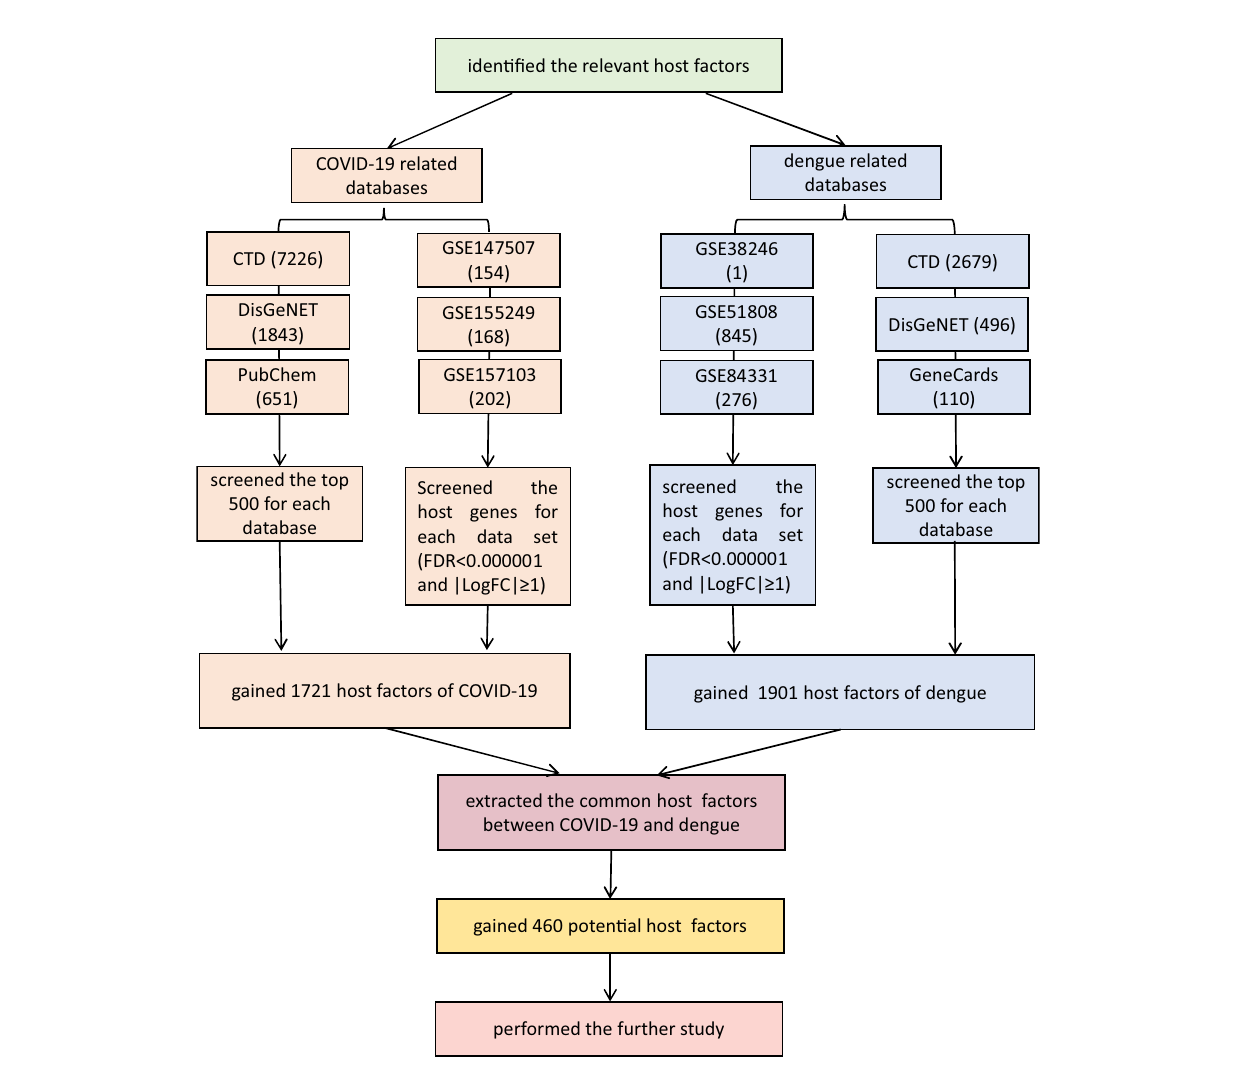
FIGURE 1 | The screening process of shared targets between COVID-19 and dengue. In total, 460 factors were shared. False discovery rate (FDR) using a Benjamini-Hochberg approach (FDR<1×10 -6 ) and |logFC| ≥ 1. Venn diagram tool (http://bioinformatics.psb.ugent.be/webtools/Venn/). CTD: Comparative Toxicogenomics Database (http://ctdbase.org/). DisGeNET: a platform containing genes associated with human diseases (https://www.disgenet.org/). PubChem: a collection of accessible chemical information (https://pubchem.ncbi.nlm.nih.gov/). GeneCards: a database of human genes (https://www.genecards.org/). GEO: Gene Expression Omnibus